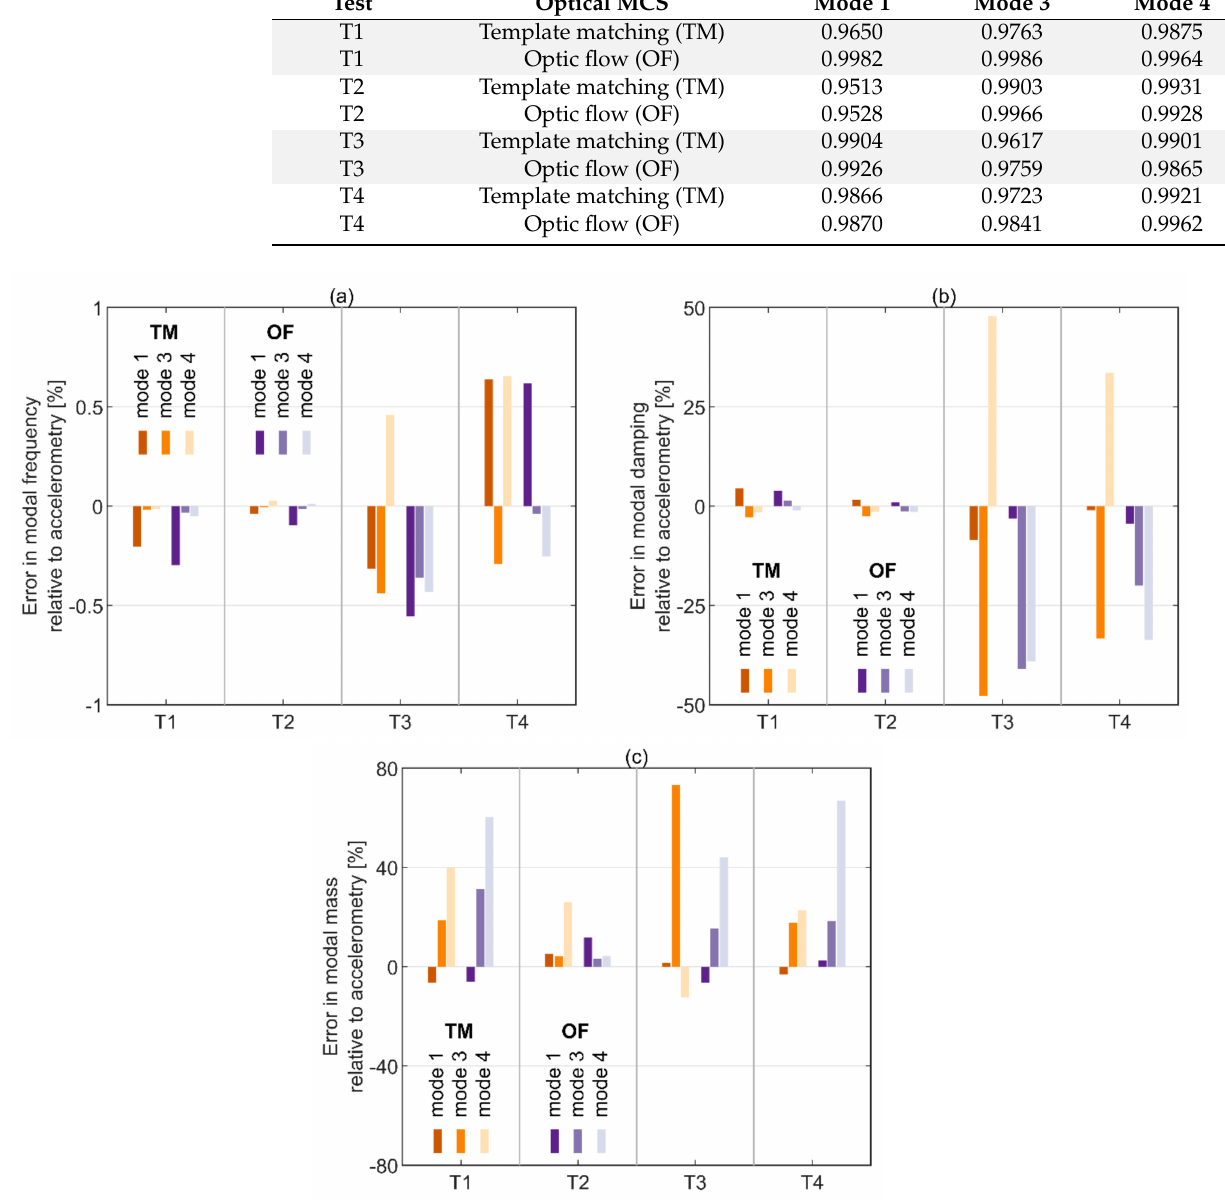
Figure 12. Errors in modal parameters obtained with optical motion capture systems: ( a ) frequency, ( b ) damping, ( c )